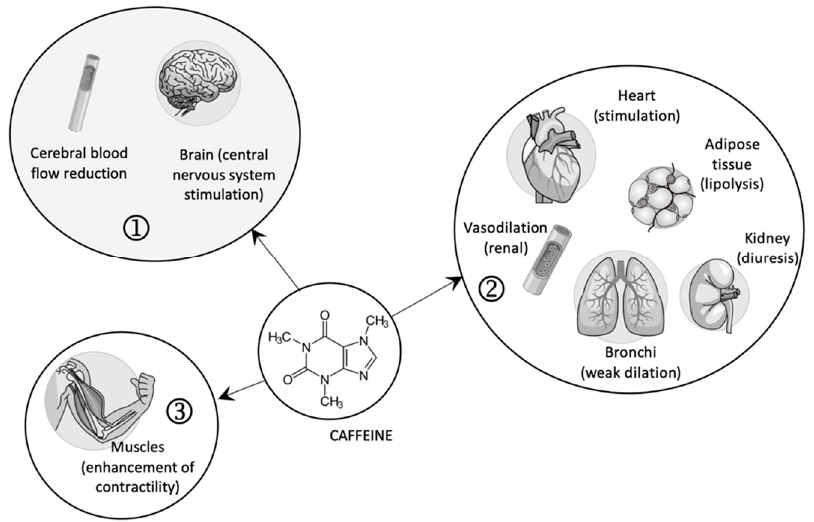
Figure 1. The pharmacological effects of caffeine (1—central effects; 2—peripheral effects; 3—contraction of skeletal muscles).